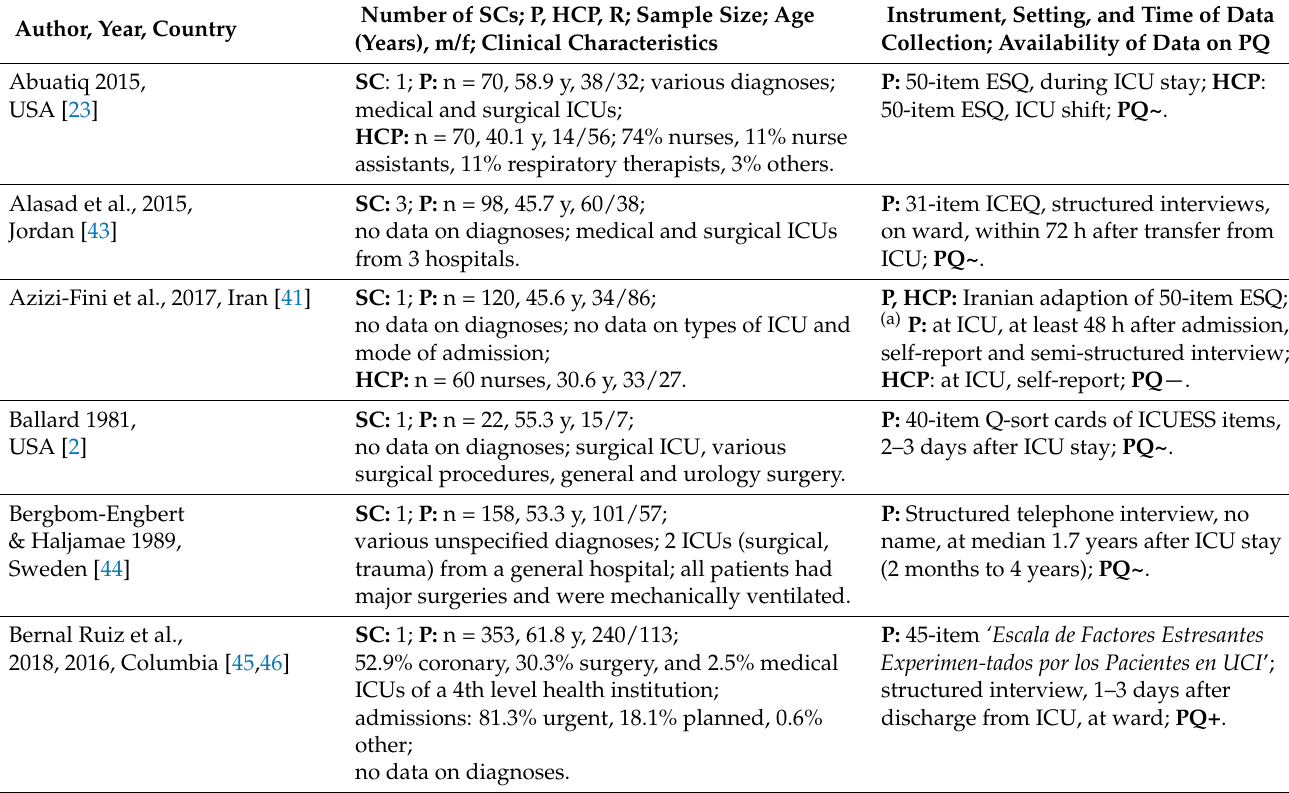
Table 1. Characteristics of 42 studies on rankings of perceived intensity of stressors in the ICU (abbreviations see table footer). Author, Year,